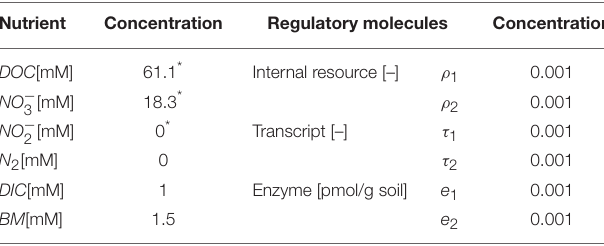
TABLE 2 | Initial condition used for the simulation of denitrification dynamics: DOC = dissolved organic carbon, DIC = dissolved inorganic carbon, and BM = biomass; ρ , τ and e denote the concentrations of internal resource, transcript and enzyme, respectively; the subscripts 1 and 2 denote the association with NO − 3 and NO − 2 reduction pathways,